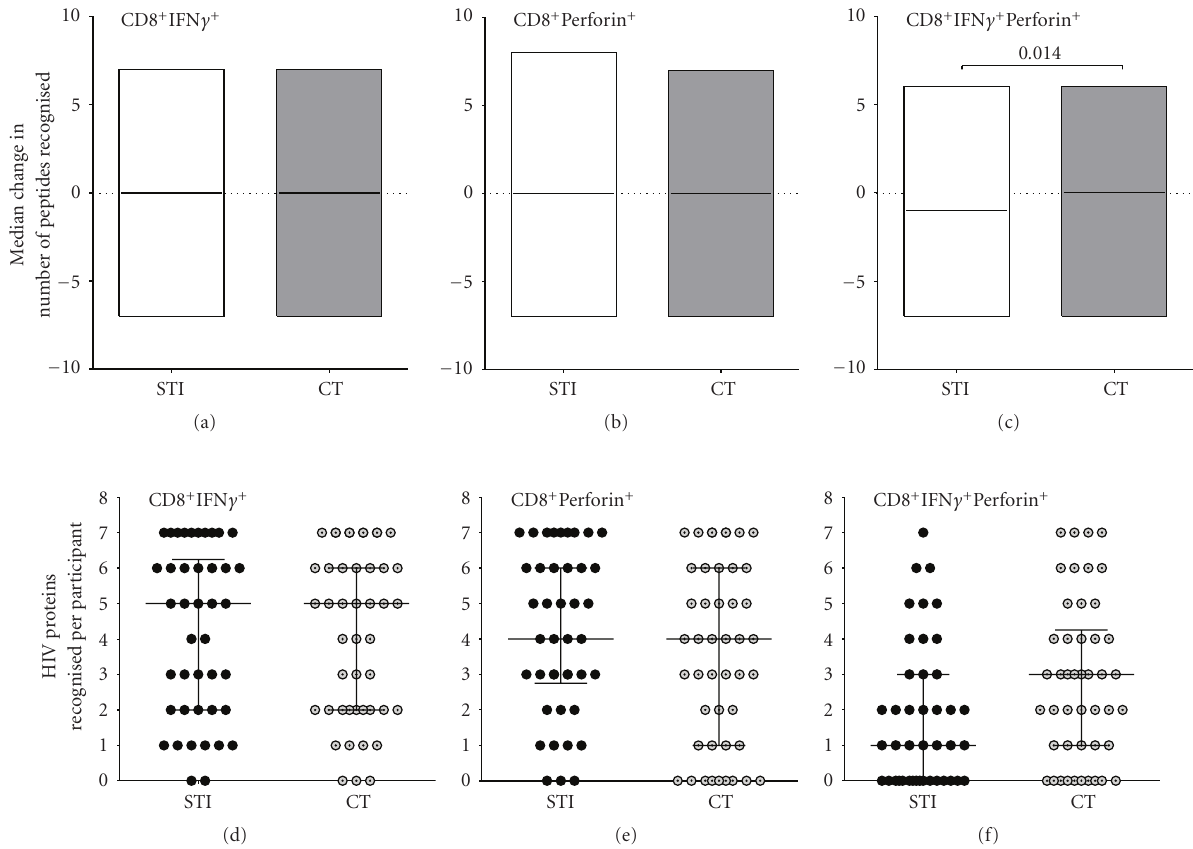
Figure 4: Breadths of CD8 + T-cell responses after 12 weeks of STI and matching time point on CT. Study participants were evaluated for CD8 + T-cell responses to complete peptide pools corresponding to Gag, Nef, Tat, Vpr, Vpu, Rev and Vif HIV proteins. Response to the two Gag pools was analysed concomitantly to represent response to the Gag protein. Breadth of CD8 + T-cell response was defined as the number of HIV pools recognised by an individual. Median change in breadth was defined as the increase or decrease in number of pools recognised. Positive readouts indicate increase while negative readouts indicate decrease. The figure demonstrates changes in the breadth of CD8 + IFN γ + (a), CD8 + Perforin + (b) and CD8 + IFN γ + Perforin + , (c) responses among CT and STI participants; and compares the median number of peptide pools targeted with the induction of CD8 + IFN γ + (d), CD8 + Perforin + (e), and CD8 + IFN γ + Perforin + (f) at the end of one STI cycle. Horizontal lines represent